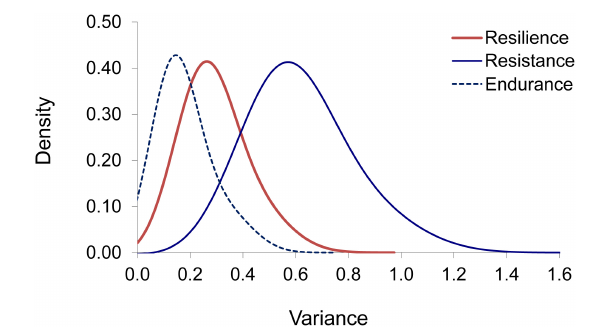
FIGURE 3 | Gram–Charlier approximations of the posterior density distributions for the additive genetic variance under Cox models for resilience, resistance, and